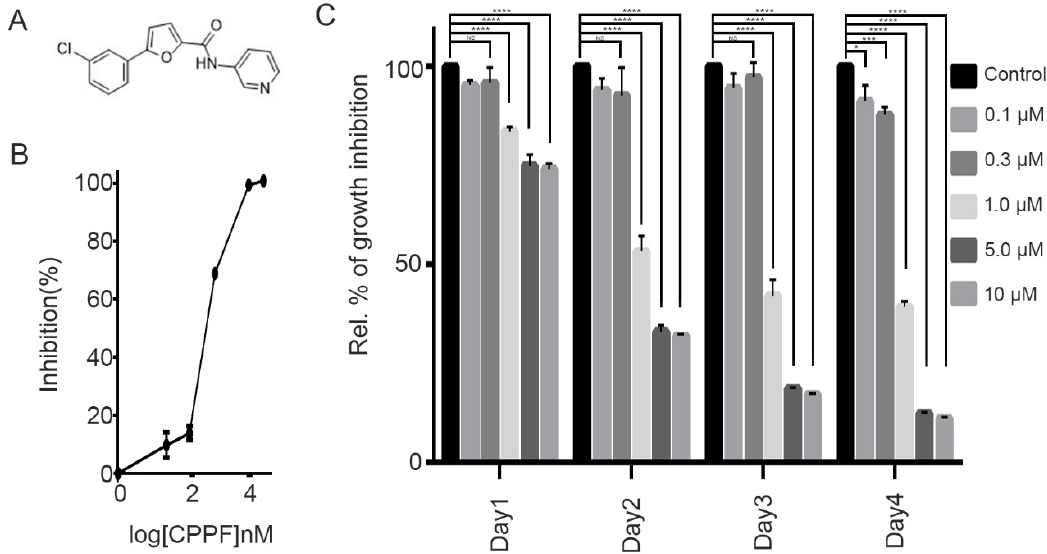
Figure 1. Structure and effect of 5-5 (3-cchlorophenyl)-N-(3-pyridinyl)-2-furamide (CPPF) on the cell proliferation of various cancer cell lines. ( A ) Chemical structure of CPPF; ( B ) HeLa cells were seeded in a 96-well plate. Cells were treated with CPPF for 4 days. Cell growth was measured at 450 nm absorbance using an MTT assay. Data were analyzed using GraphPad Prism software. Error bars represent means ± SD from three independent experiments ( C ) HeLa cells were seeded in a 96-well plate and treated with different concentrations of CPPF. Cell growth was measured at 1 day, 2 days, 3 days and 4 days after treatment using an MTT assay. Error bars represent means ± SD from three independent experiments, * p- value < 0.05, *** p- value < 0.001 and **** p- value < 0.0001, NS: Not significant.